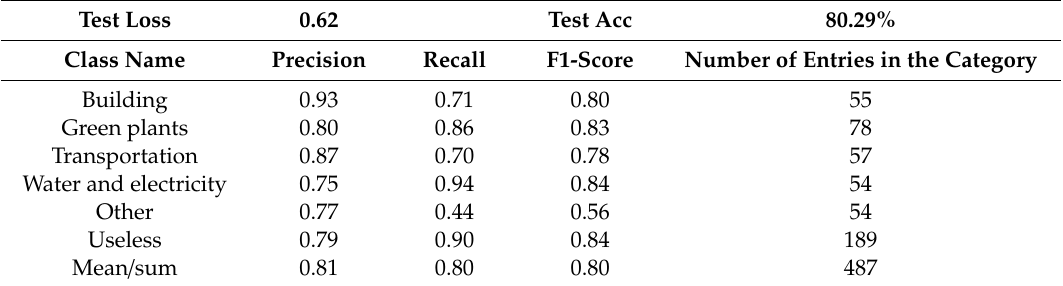
Table 3. Test result.